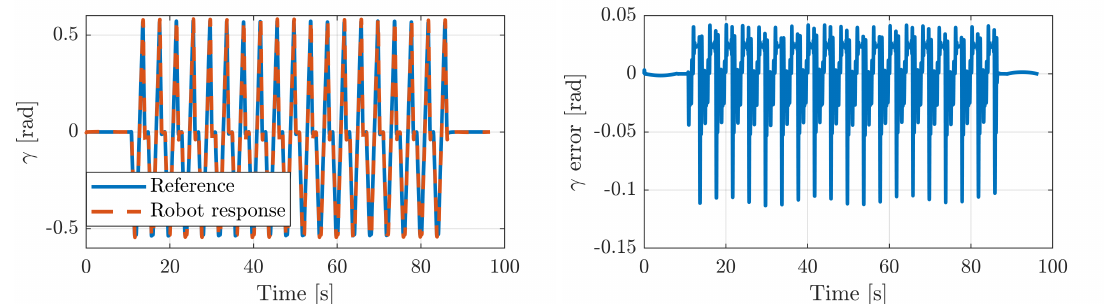
Figure 13. Mobile platform pitch of the Simulink model of the rehabilitation robot.